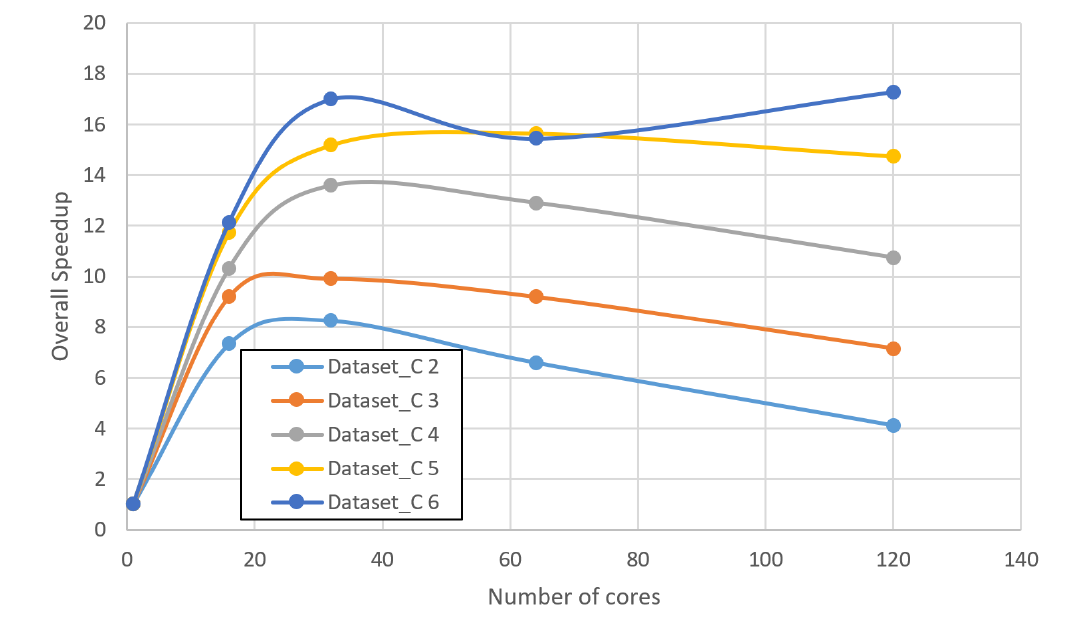
Figure 11. Speedup achieved by the parallel SCLS on Spark for various data sizes with different numbers of